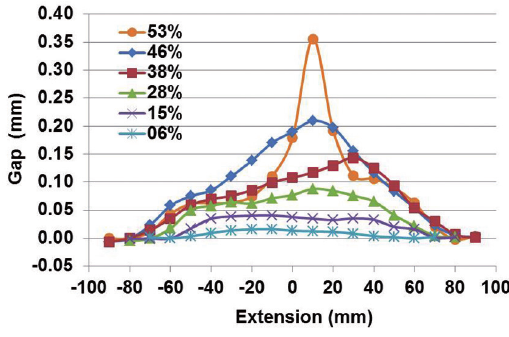
Figure 6: Gap profile along the test specimen as a function of axial deformation.